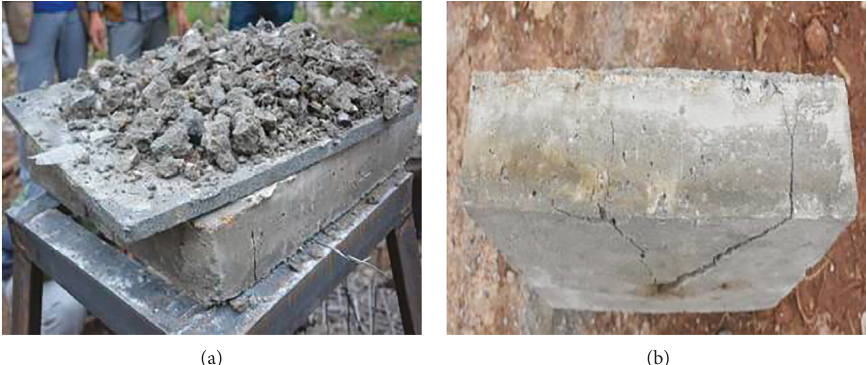
Figure 14: Blast damage phenomena from Tests 2 and 3. (a) Damage to the upper layer. (b) Bottom of the lowest plate.